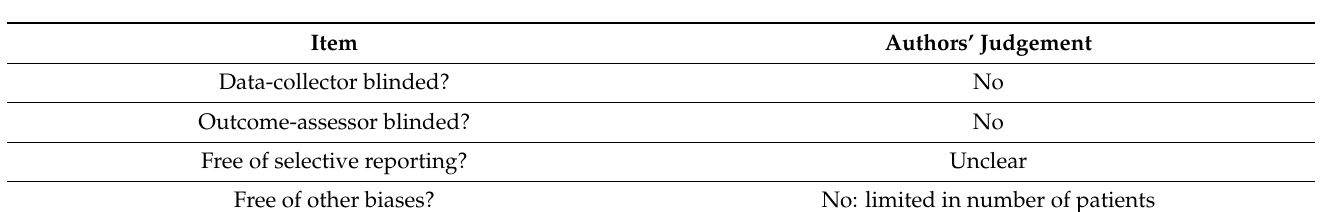
Table A3. Risk of